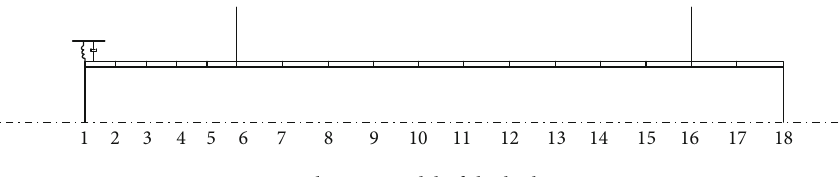
Figure 6: Finite element model of the high-pressure rotor.